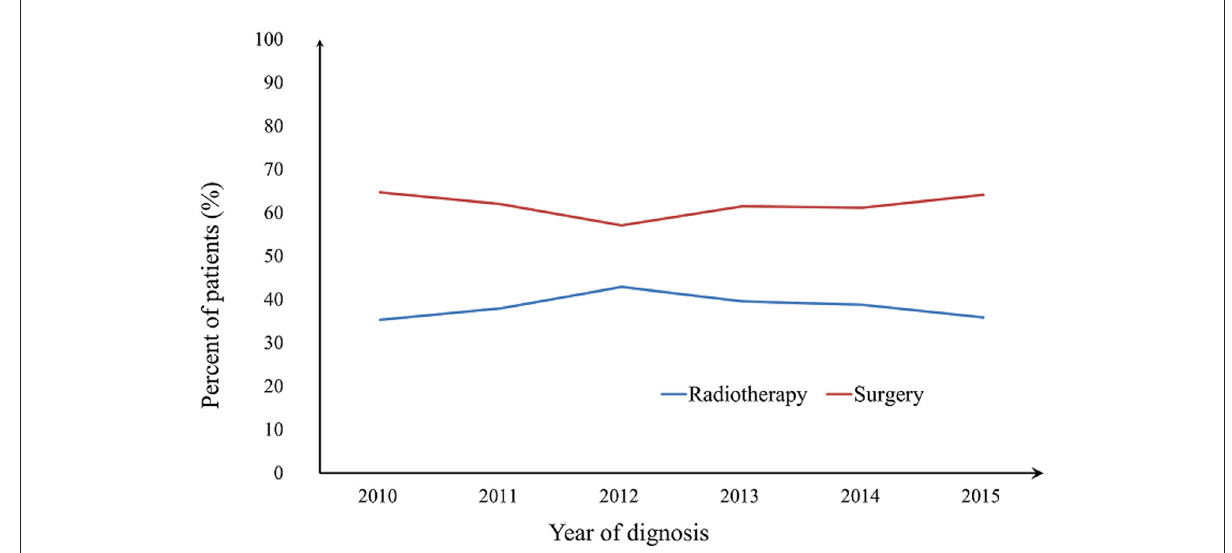
FIGURE1 Patients’ treatment strategies according to the year of diagnosis.